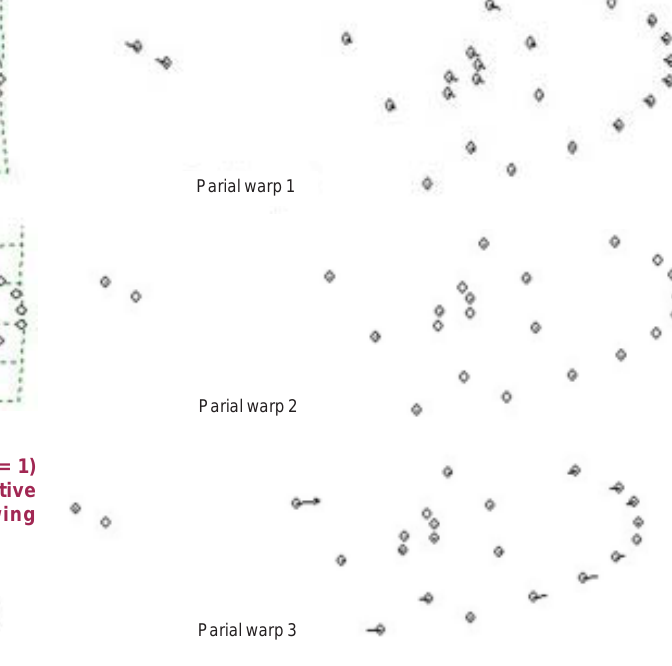
Figure 7. Plots of last three principal warps as displacement vector equally for x and y coordinates (Alpha = 0)